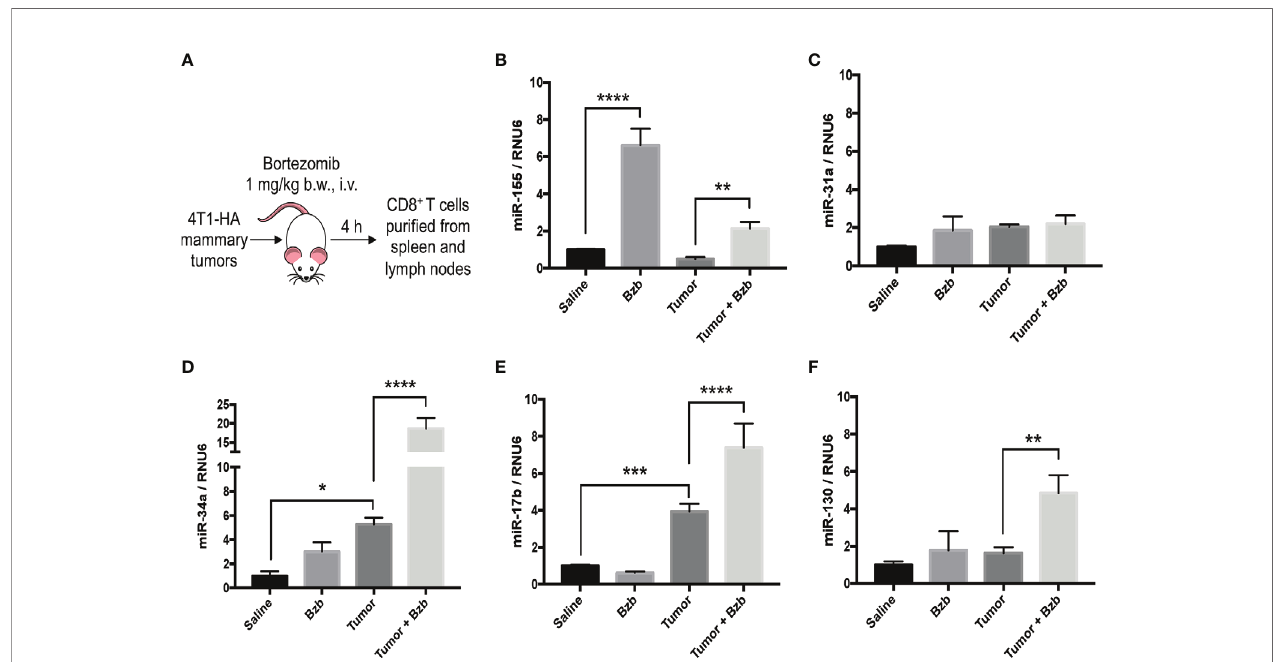
FIGURE 2 | Bortezomib increases CD8 + T cell miR-155 expression in mice with or without mammary tumors. Mammary tumors of at least 120 mm 3 in size were established in a cohort of BALB/c wild-type (WT) mice by orthotopic injection of 2 x 10 6 4T1-HA tumor cells into mammary pads. Mice were treated with bortezomib intravenously (1 mg/kg b.w.) and euthanized 4 h post injection. CD8 + T cells were puri fi ed from a pool of spleen and lymph nodes (A) . Expression levels of miR-17b, miR- 31a, miR-34a, miR-130, and miR-155 were determined in CD8 + T cells by RT-PCR. Values were compared with groups injected with saline (B – F) . Data are presented as mean values ± SD from four independent experiments; * p < 0.0066, ** p < 0.0021, *** p < 0.0003, **** p < 0.0001 compared to saline; n = 6 per group (ANOVA, one-way).